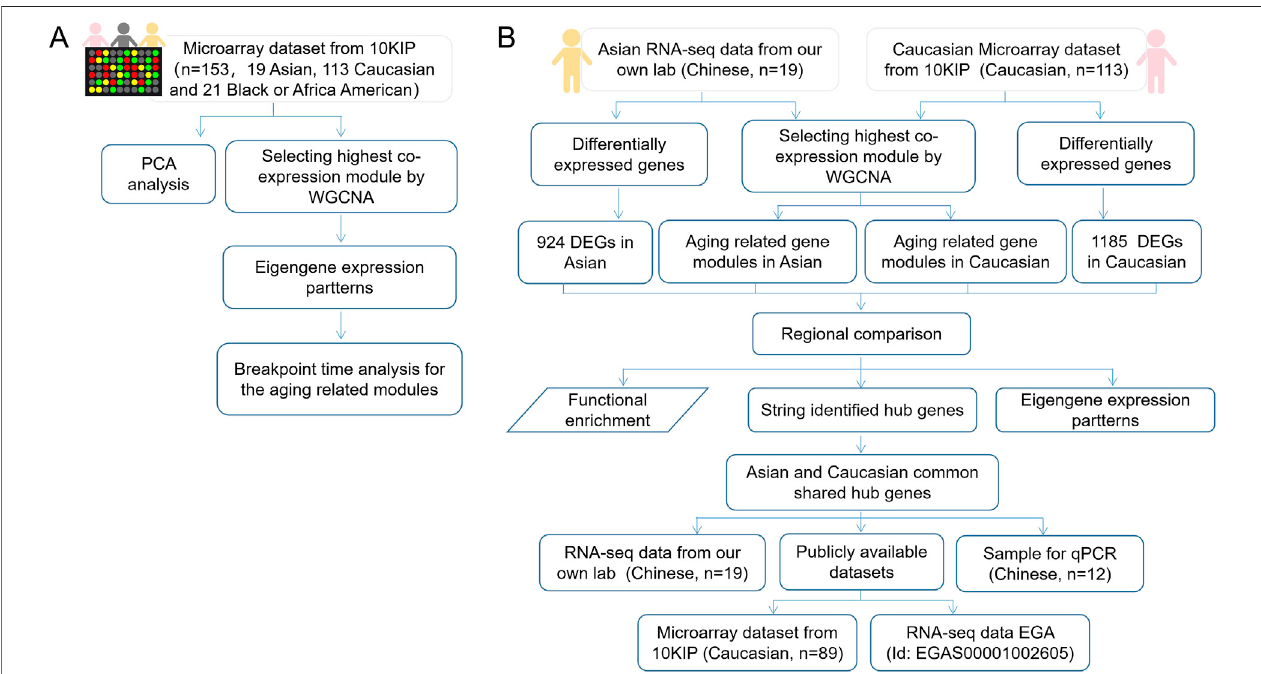
FIGURE 1 | The fl ow chart of overall study. (A) A total analysis of 153 healthy human subjects in 10KIP. (B) The anlysis of 133 Caucasian individuals and 19 Asian (Chinese) individuals.